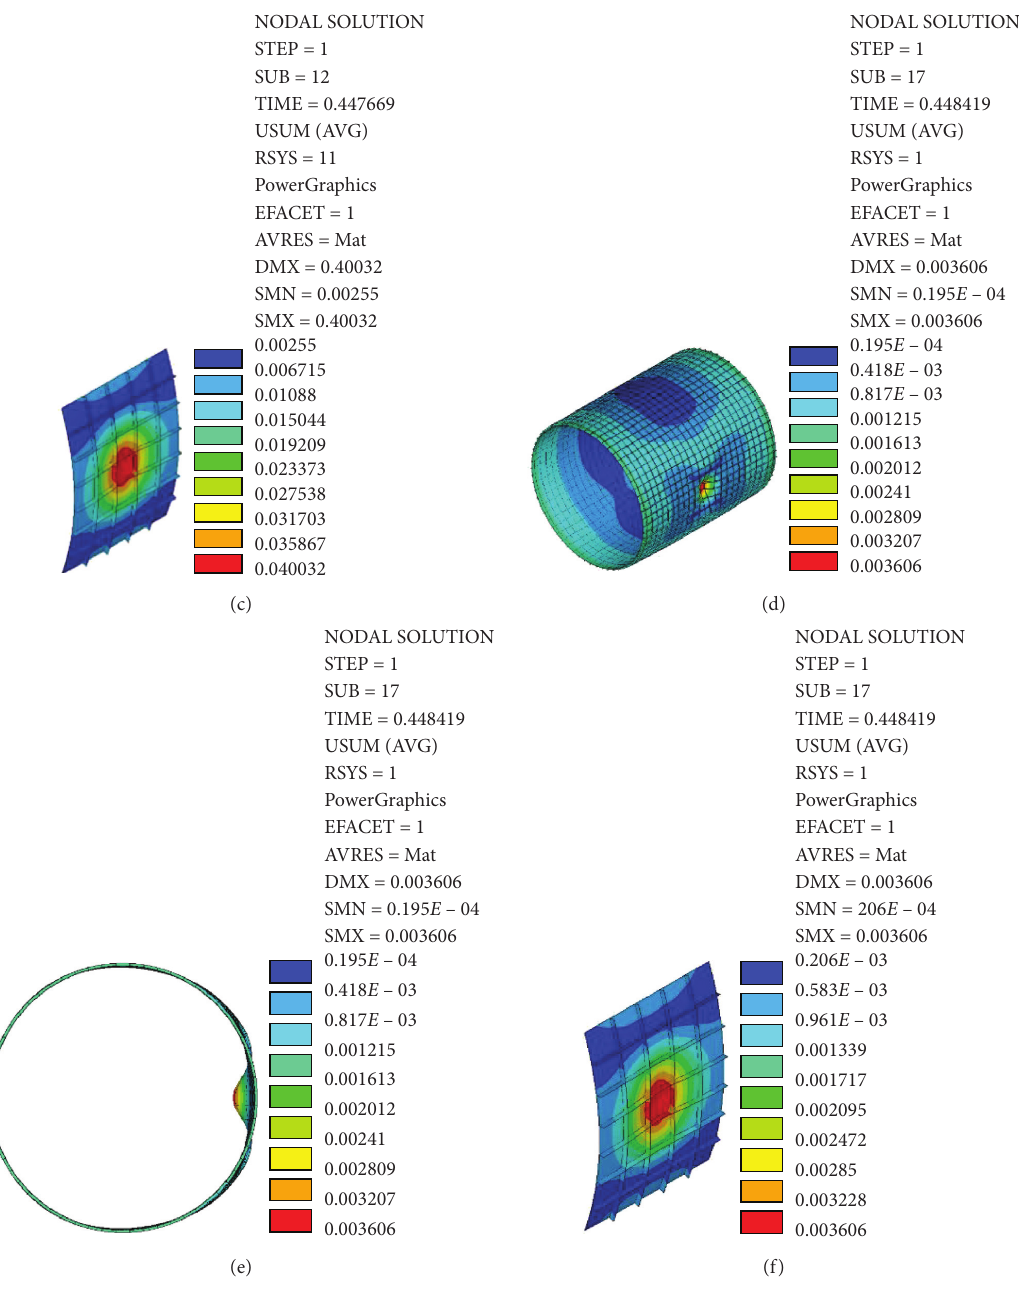
� 0.720m, λ � 0.072m, and p m